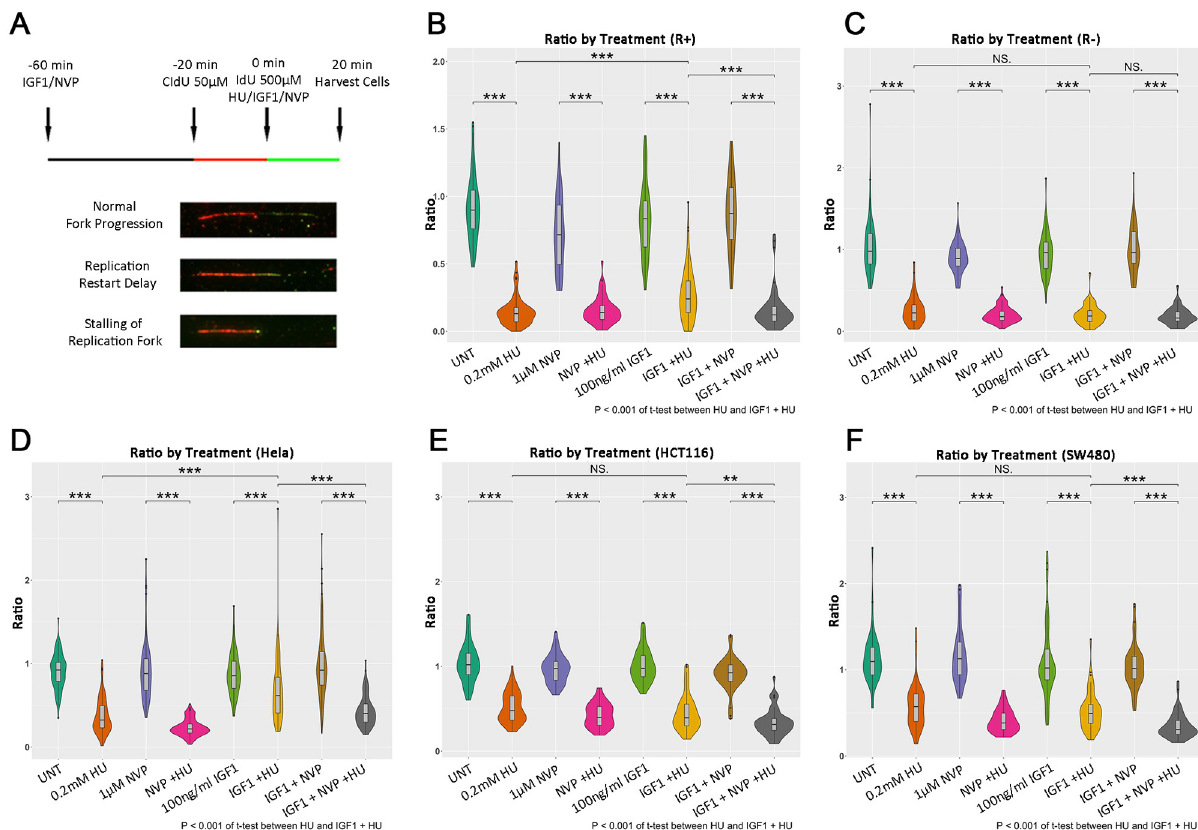
Fig 6. IGF1R rescue stalled DNA replication forks in cervical cancer cells. nIGF1R involved in restart of DNA replication fork stalling induced by Hydroxyurea (HU). The upper panel of (A) shows a schematic figure that illustrates the experiment procedure. At 60 min before HU treatment, 100ng/ ml IGF1, 1 μ M NVP or 100ng/ml IGF + 1 μ M NVP were added to different treatment groups. After incubating for 40 min, 50 μ M CIdU (red) was added to all treatment groups in order to pulse-label the DNA for 20 min. Cells were then washed twice by warm medium and labeled again with medium with 500 μ M IdU (Green). The treatments of 0.2mM HU as well as the IGF1, NVP and IGF1 + NVP in different groups were supplemented in the mediums synchronously as indicated (B-F). After incubating for another 20 min, samples were harvested by trypsin digestion for further analyses. The lower panel of (A) shows typical staining appearances of fork events as detected by DNA fiber assay. In (B) R+ cells, (C) R- cells, (D) HeLa, (E) HCT116 and (F) SW480 replication restart speed was represented by the ratio of the lengths of nascent replication tracts after inducing DNA damage labeled with IdU (green) to the length of the replication tract before inducing damage labeled with CIdU (red). At least 50 unidirectional forks labeled with both CIdU and IdU were measured for each